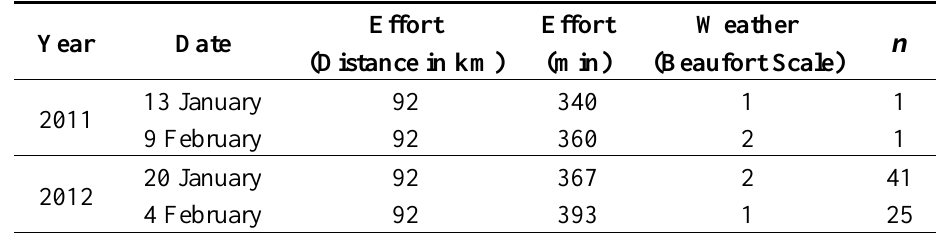
Table 1. Date, effort, weather conditions and number of blue whales sighted on each systematic survey conducted in 2011 and